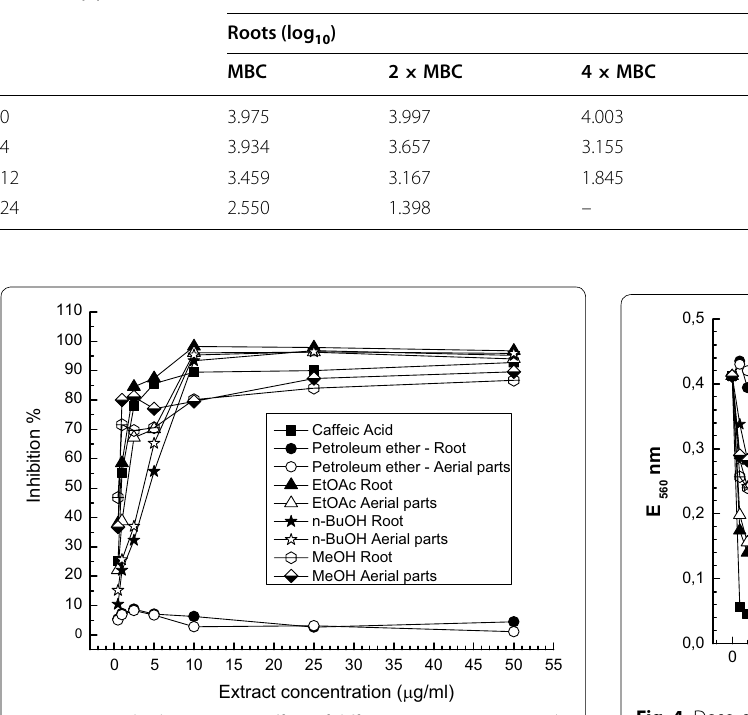
Table 2 In vitro time-kill assay of EtOAc fractions from aerial parts and roots of G. urbanum against B. cereus ATCC 9634 Intervals (h)